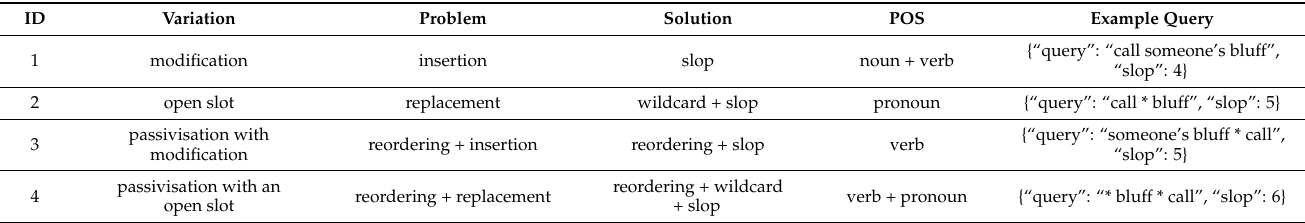
Table 1. Summary of query